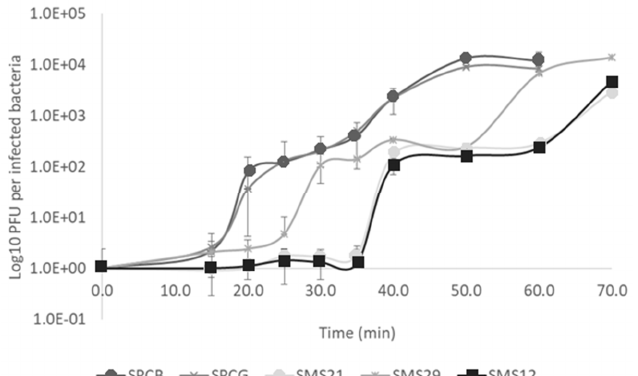
Figure 3. One-step growth characteristics of the five phages used. Data are shown as mean ± SD.